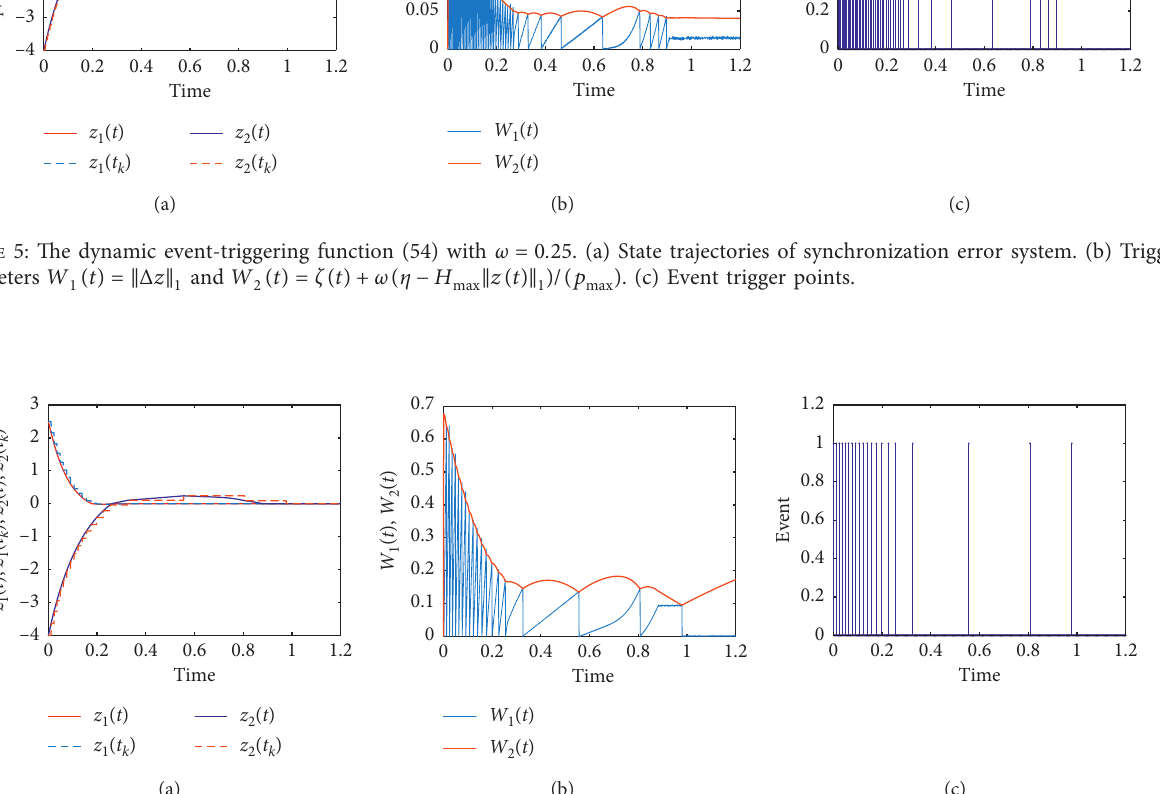
‖ z ( t )‖ ) / ( p ) . (c) Event trigger max 1 max